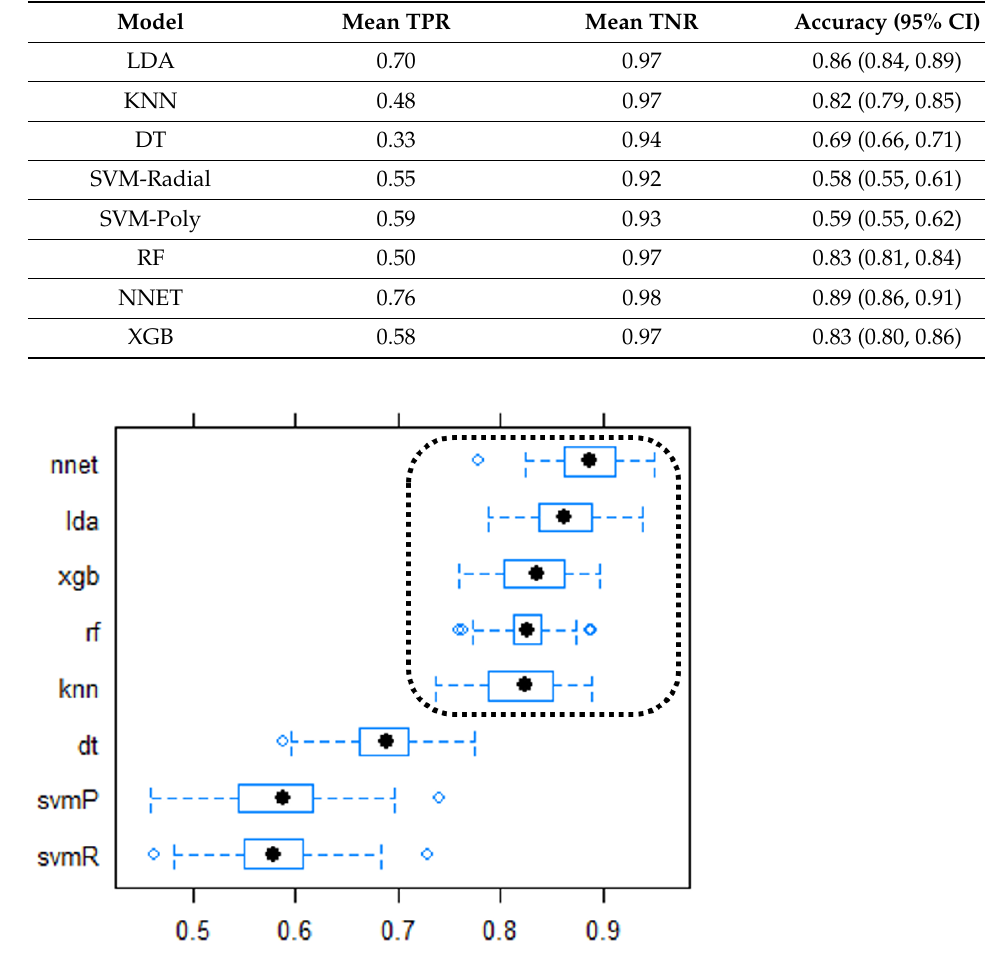
Table 2. Layer-1 Training Performance (4-Bus System).